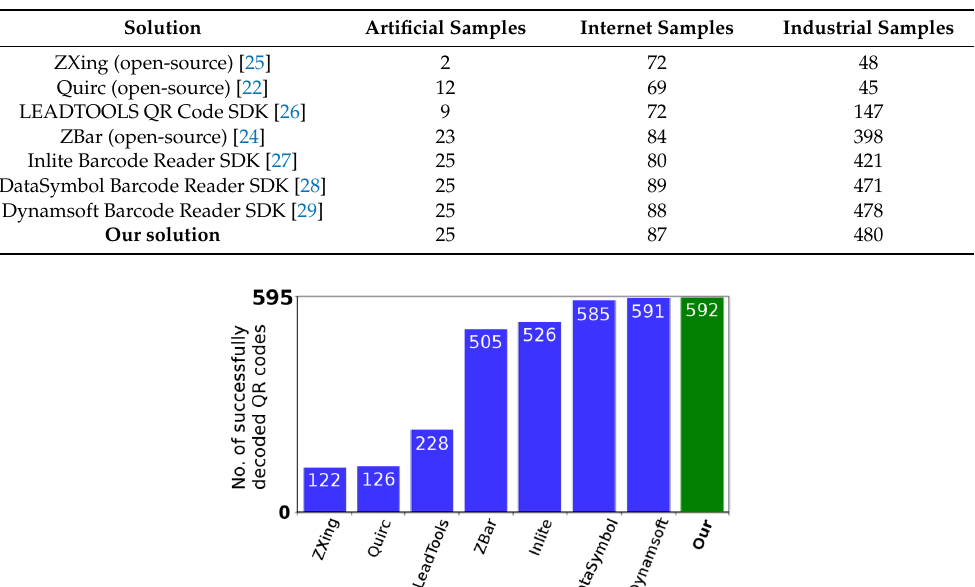
Table 1. Comparison of competing solutions with our proposed method.